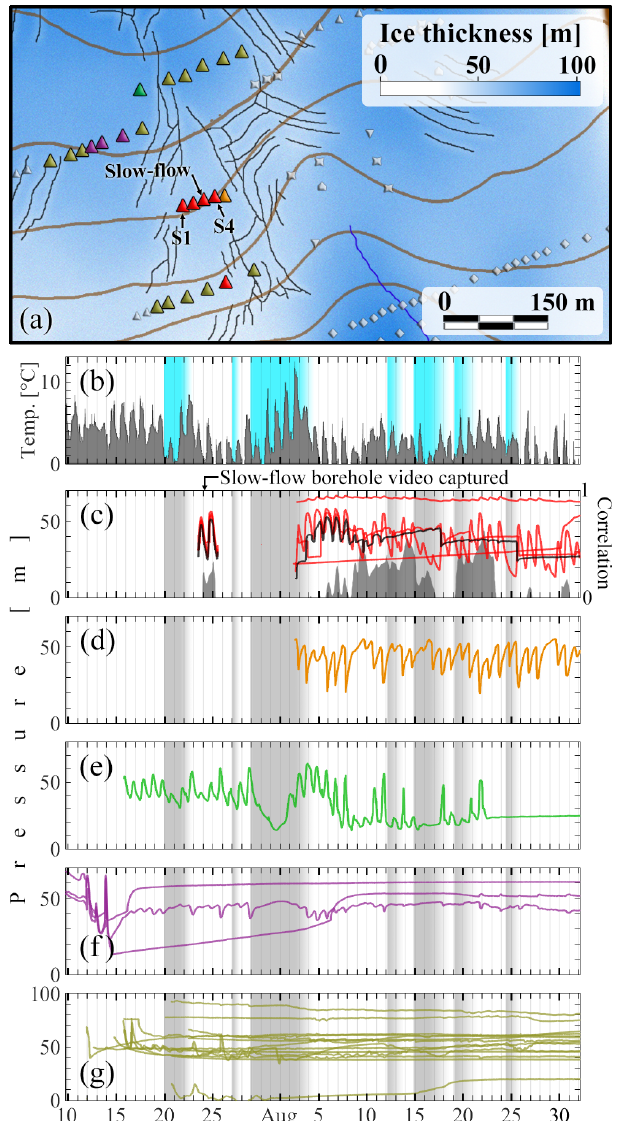
Figure 6. Locations and pressure time series for the boreholes asso- ciated with the slow-flow borehole on July and August 2014, with the same plotting scheme as Fig. 5 (see corresponding caption). Panel (c) shows pressure in the slow-flow borehole (black) and three other boreholes in the same line. The correlation with temperature has been calculated using the only borehole that remains connected over the whole interval. The remaining panels show pressure time series from other nearby holes as indicated by the line and borehole marker colours. The time series from boreholes S1–S4 are shown in more detail in Fig. 7.